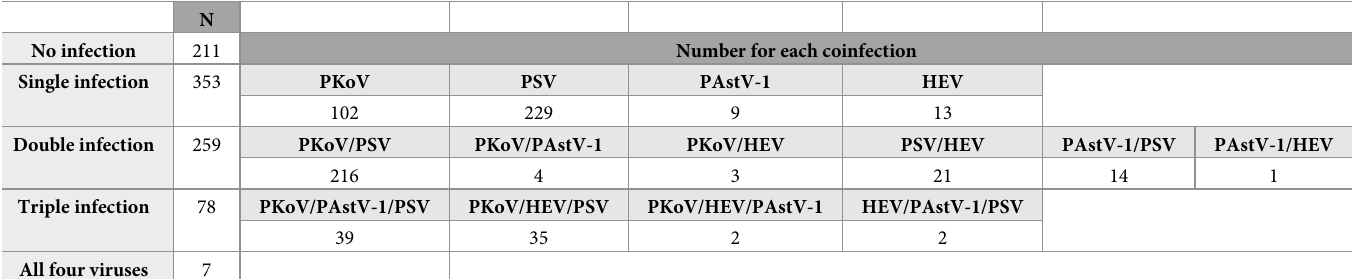
Detection rate of viral RNA at the farm level. At least one pig was detected positive for PKoV RNA in each of the 16 pig farms sampled (100%), 62.5% for PAstV-1 infection (n = 10/16) and 93.8% for PSV infection (n = 15/16). The positivity rate at farm level ranged between 22.5% and 80.8%, 0.0% and 34.0%, and 0.0% and 87.5% for PKoV, PAstV-1 and PSV, respectively. The detail of the detection rates of the three viruses for each farm were presented on the S1 Table.